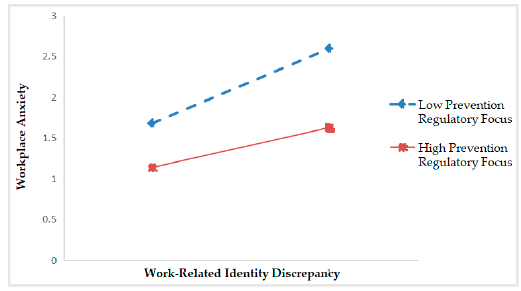
Figure 3. Moderation effect of prevention regulatory focus.